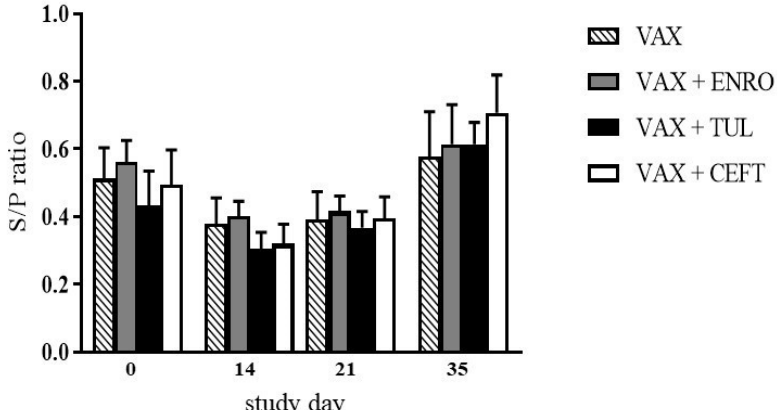
Figure 2. Assessment of PCV-2 S / P ratio over time for weanling pigs administered di ff erent antibiotics. There was no di ff erence in PCV-2 S / P ratios when vaccinated pigs (VAX, diagonal bars) were compared to vaccinated pigs administered the three di ff erent antibiotics (n = 8 pigs per antibiotic treatment group, solid bars, see legend, each bar represents mean +